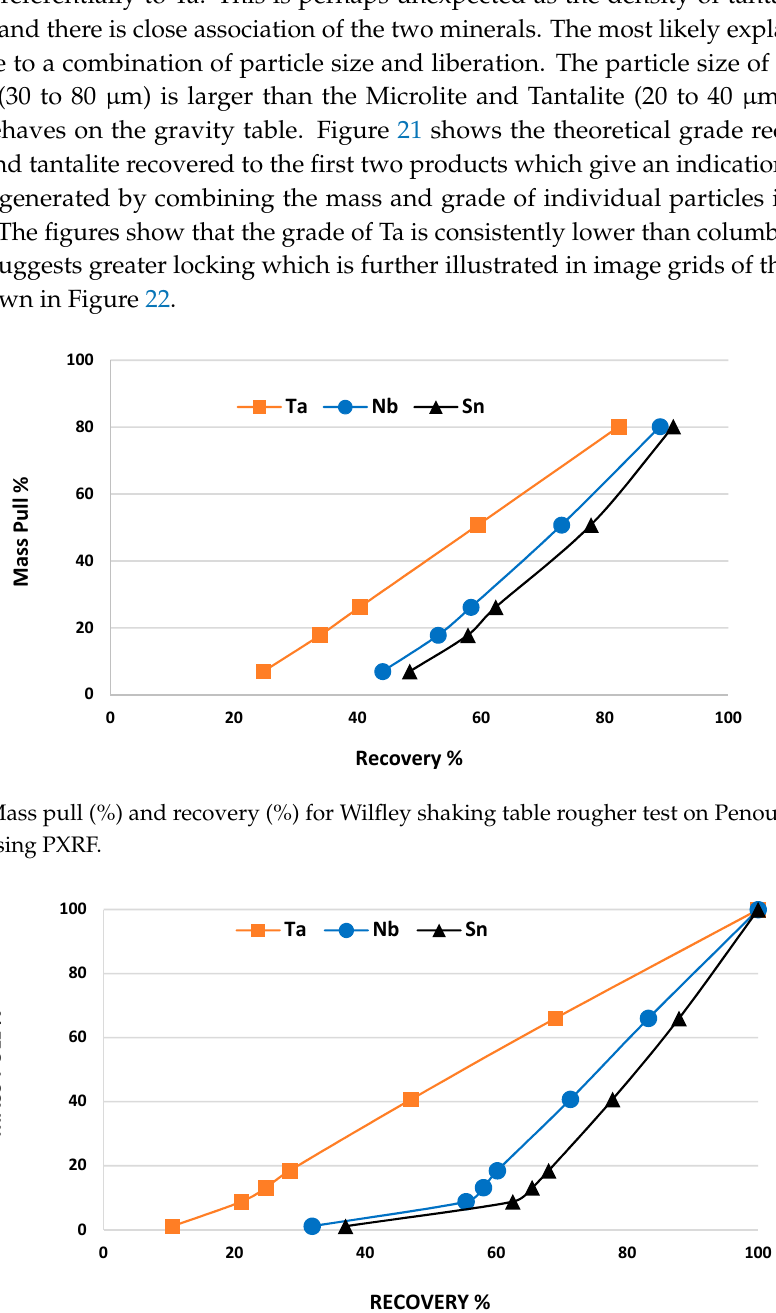
Figure 21. Columbite and tantalite theoretical grade recovery curves for the first two concentrate products of Wilfley separation.